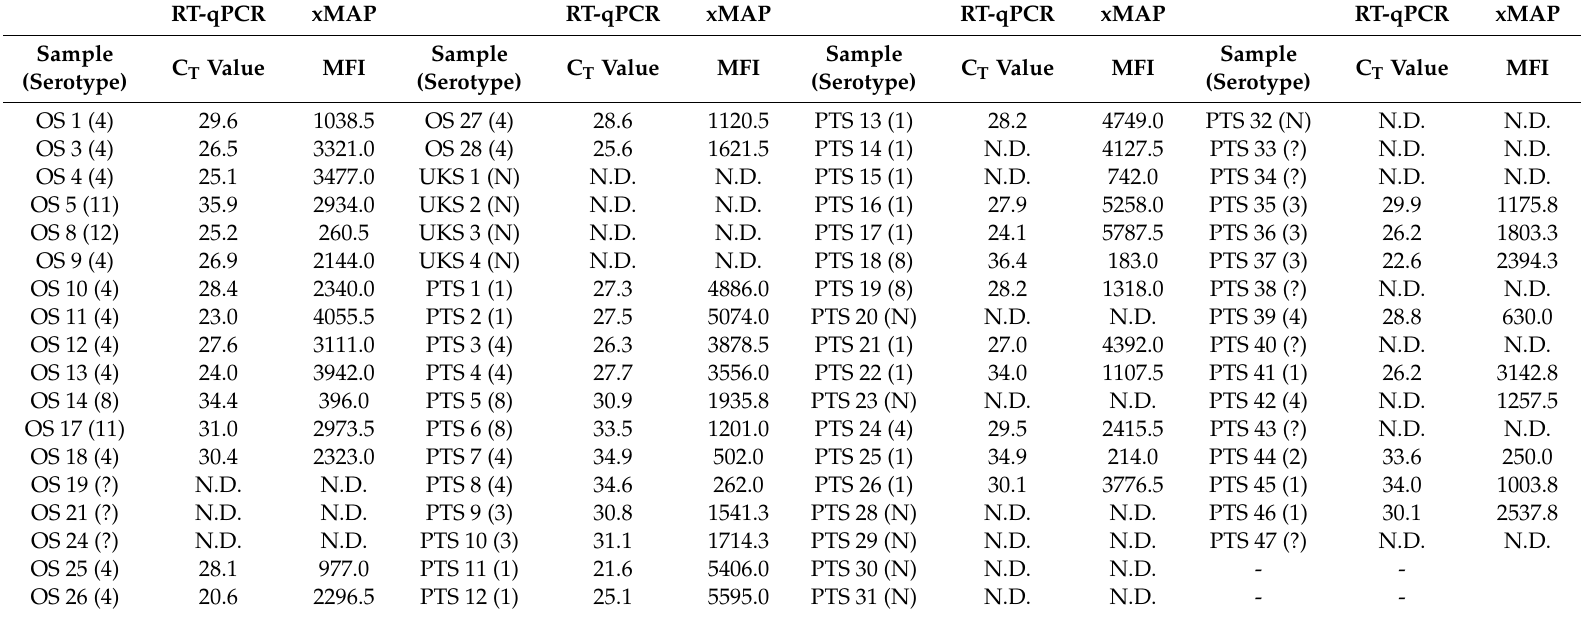
Table 2. Performance of serotype-specific RT-qPCR assay and xMAP assay on samples containing a single